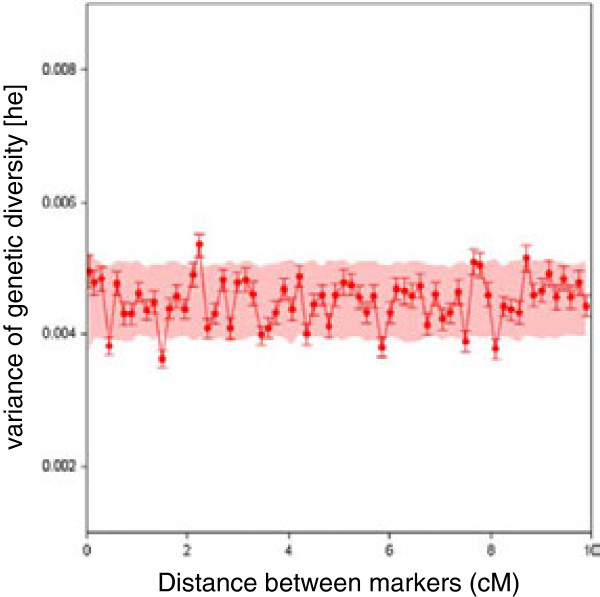
Empirical pangenomic variogram of genetic diversity (He) plotted against map distance, ranging from 0 to 10 cM (0.15 cM as the lag size). The red dots (connected by a red line for trend detection) represent the variance of He for each pair of markers for a given class of map distance. The bandplot indicates the 95% confidence interval.